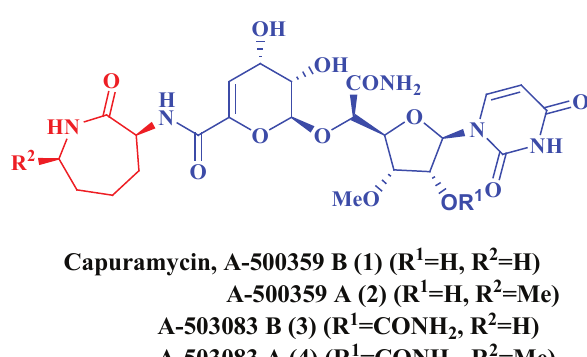
Figure 1: Capuramycin and its congeners.